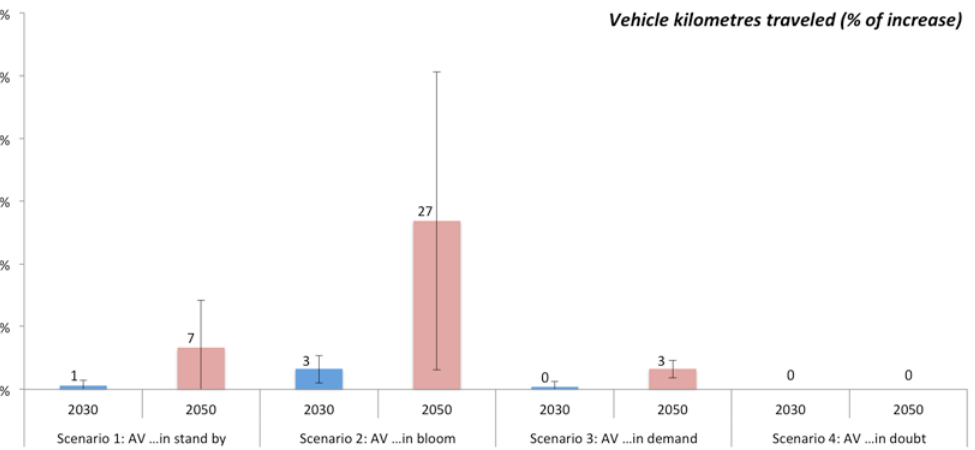
Figure 6. Estimation of change in total vehicle kilometres travelled in different scenarios. Each bar represents average value of five experts responses collected in Delft University of Technology workshops and error bar depicts standard